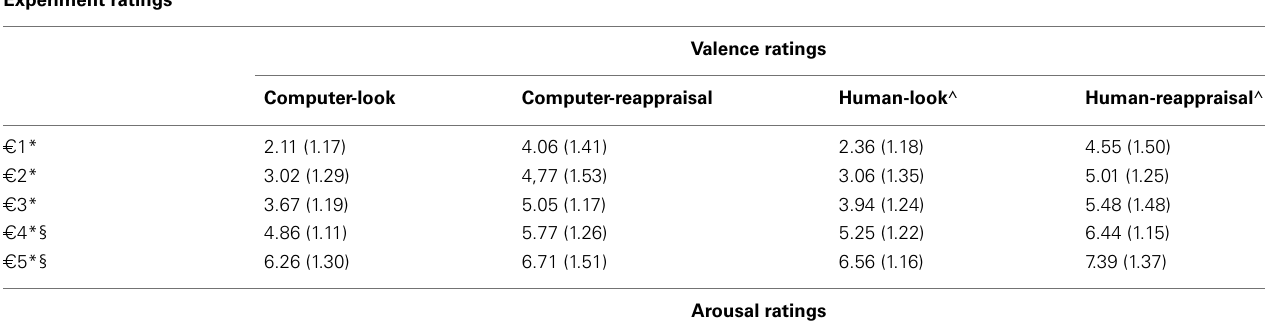
Table 2 | Experiment 2-results from the experiment and from the questionnaires. Experiment